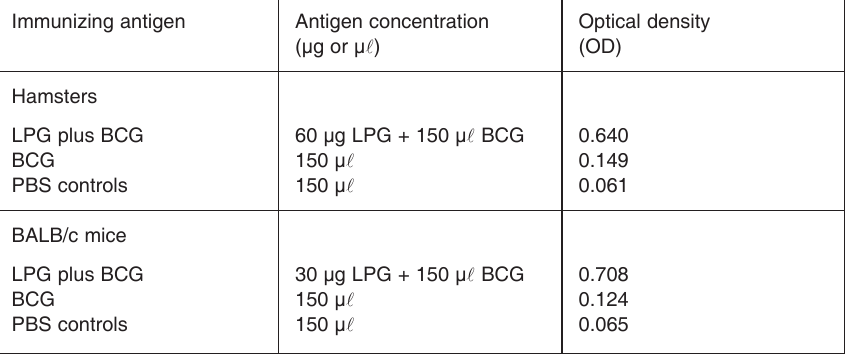
TABLE 1 Antibody responses (IgG) of BALB/c or hamsters to LPG following a triple vaccina- tion with LPG plus BCG Immunizing antigen Antigen concentration